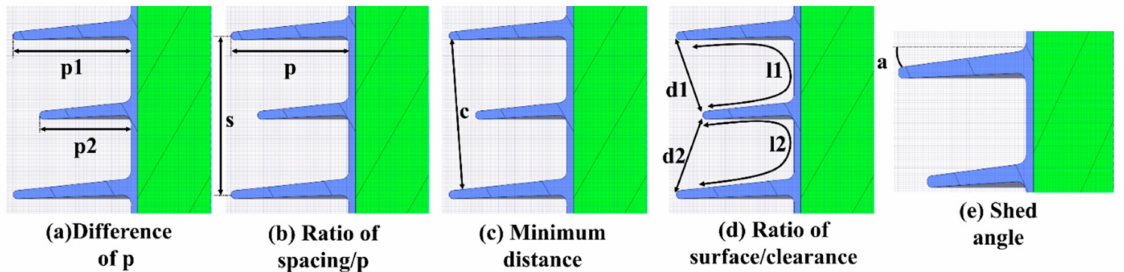
Figure 6. Design factors in IEC 60815-4 when designing the shed of an insulator.